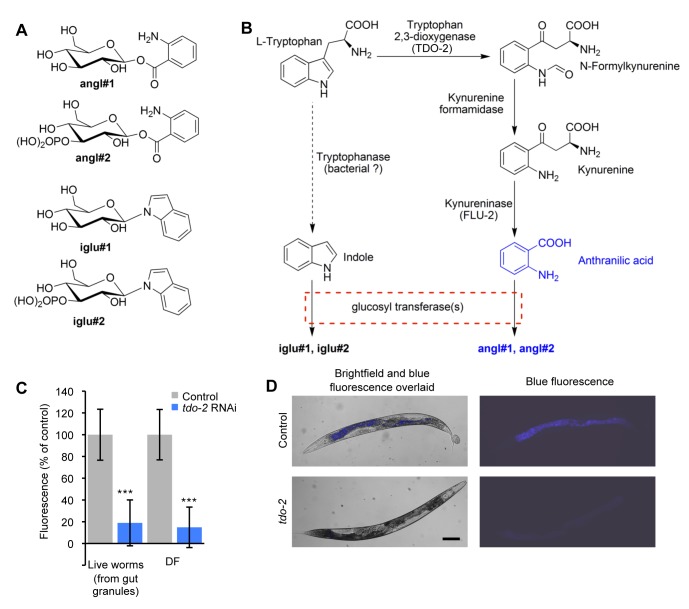
DF is generated by the kynurenine pathway.(A) Compounds down-regulated in glo-1(zu437) background. (B) Anthranilic acid (AA) is derived from tryptophan via the kynurenine pathway. angl#1 and angl#2 may result from action of glucosyltransferases. (C and D) RNAi of putative tryptophan 2,3-dioxygenase (C28H8.11) significantly reduces both gut granule and DF. Bar, 100 µm, error bars ± SD. Negative fluorescence shown by error bars are due to normalization via subtraction of background fluorescence.